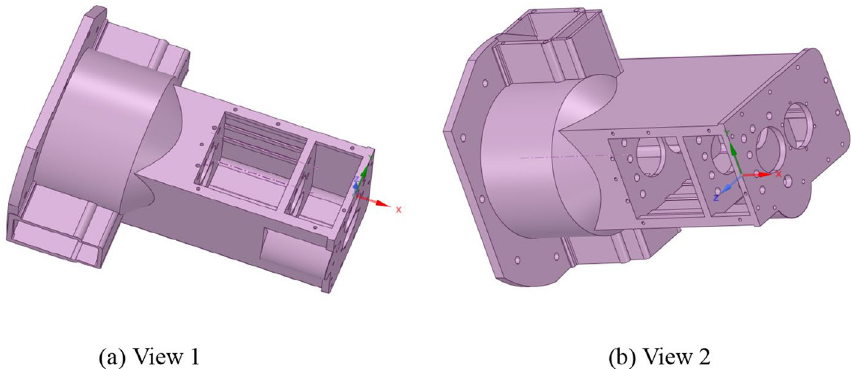
Figure 14. The optimized model of the gearbox.